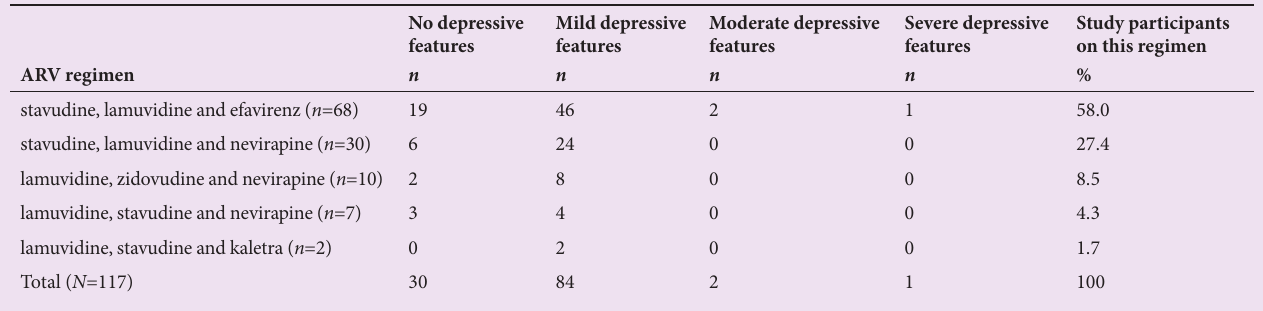
Moderate depressive features